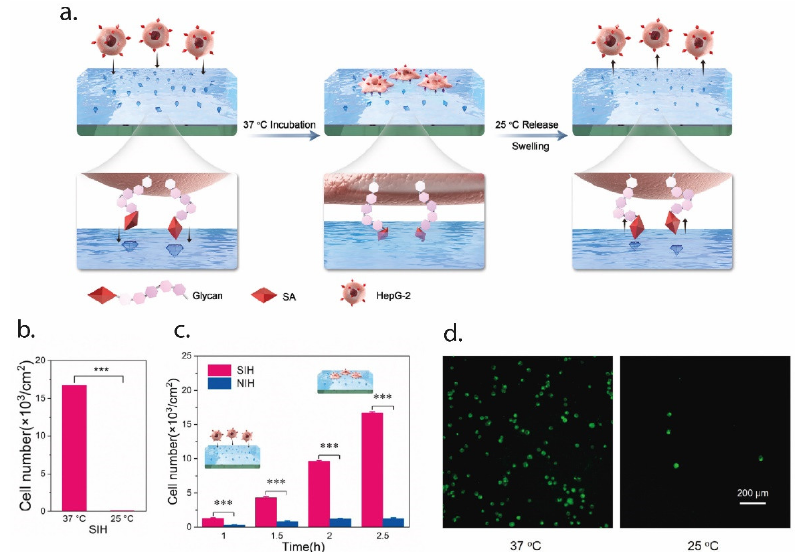
Figure 3. An example of EI for the selective capture and release of cancer cells. In ( a ), a schematic representation of the process. The SA epitope is imprinted over the surface of the PNIPAAm hydrogel; at 37 ◦ C, the epitope is exposed on the surface, so that cancer cells can bind to it. When lowering the temperature to 25 ◦ C, the conformational changes in the thermo-responsive hydrogel cause the cell release, since the SA group is no longer exposed. In ( b ), the efficiency of the cell capture-and-release method, expressed in terms of the cell number, while in ( c ) the capture profile over time compared to the non-imprinted hydrogel (NIH). Finally, in ( d ) the staining of the cell on the hydrogel surface at 37 ◦ C (captured cells) and 25 ◦ C (released cells). Figure modified with permission from